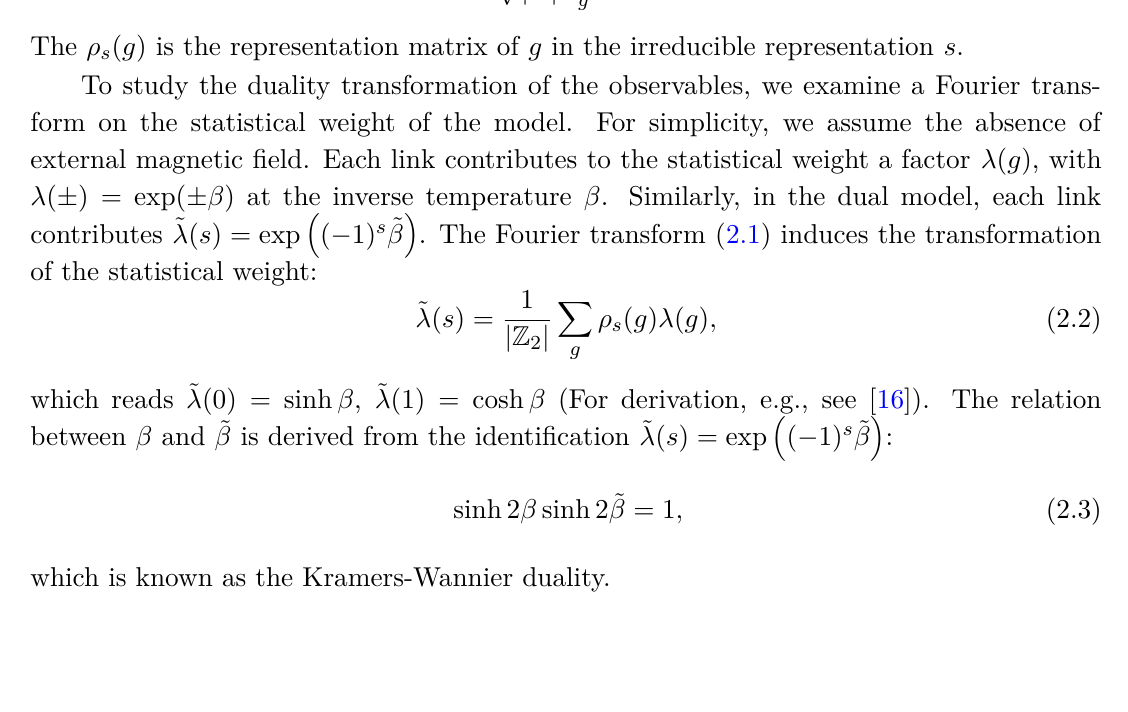
} ↔ { σ z } . v p and v 1 2